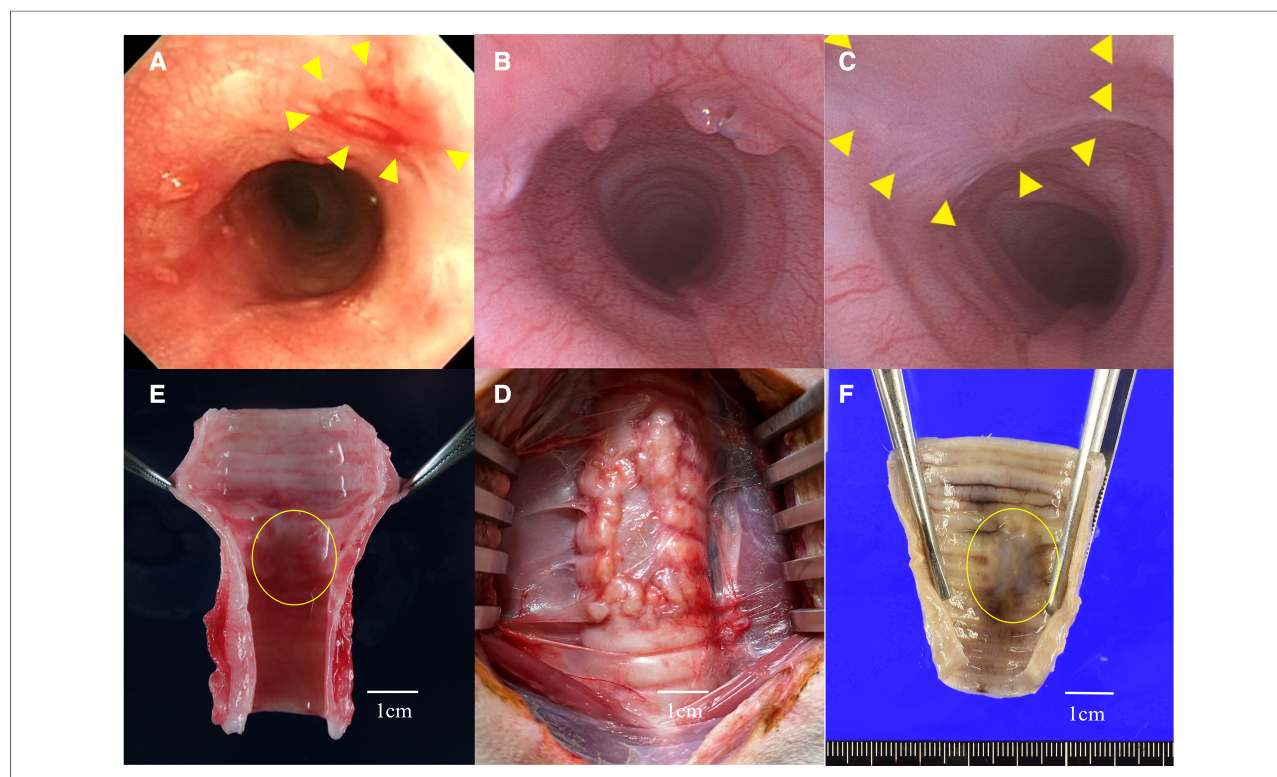
FIGURE 6 ( A ) Group A : bronchoscopic view of the graft site at3 month after surgery. The graft site showed mild redness and scarring, and the lumen was mildly constricted. ( B ) Group B : bronchoscopic view of the graft site at 1 month after surgery. Granulation around the graft was noted and the lumen was mildly narrowed. ( C ) Group B : bronchoscopic view of the graft site at 3 months after surgery. Granulation was resolved and no stenosis was observed. It was dif fi cult to distinguish the border between the graft and host sites, and the epithelium was continuous. Triangles indicate the grafted area. ( D ) The circled area indicates the porcine extracellular matrix (P-ECM). In group A (G-A), the P-ECM site was shrunken, and the original defect site showed longitudinal contraction. ( E ) The P-ECM at three months after surgery in group B (G-B) the graft site was replaced with a thin membrane tissue. ( F ) In G-B, contractile changes around the P-ECM were not